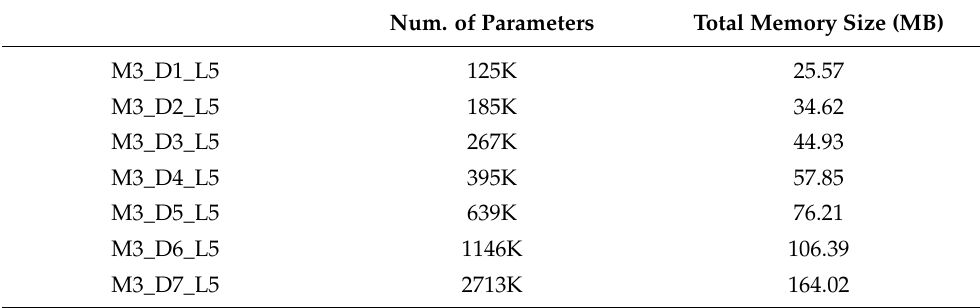
Table 8. Verification of the number of dense layer (L) per a dense block in terms of network com- plexity.